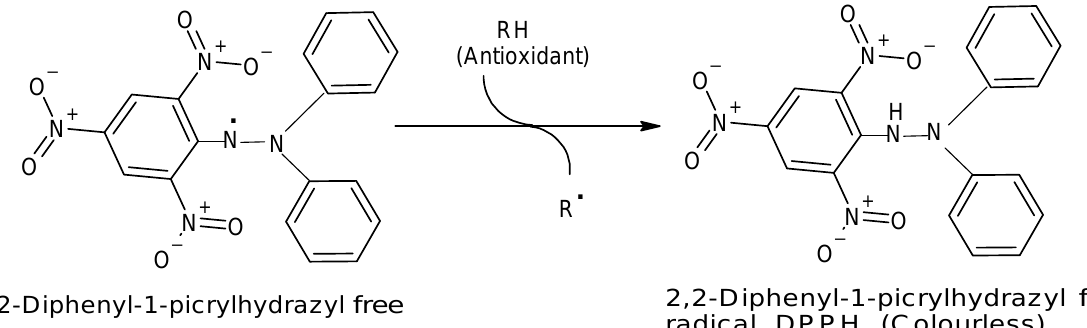
Figure 1. Reaction between DPPH radical and an antioxidant to yield the colorless DPPH. The reaction of DPPH radical with other radicals, hydrogen atoms, or electrons results in the loss of color at 515 nm. (Chemical structures produced with ACD/ChemSketch Freeware Version 2021.1.0 C25E41).